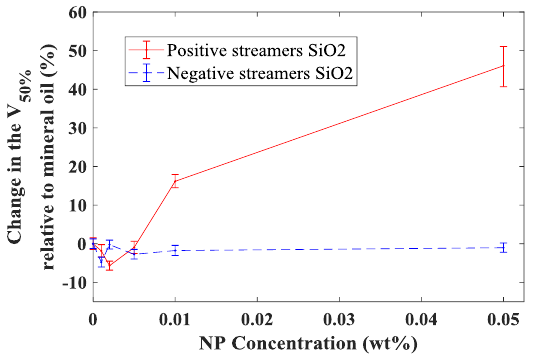
Figure 4. Change in 𝑉 50% of SiO 2 nanofluids relative to mineral oil as a function of mass fraction 𝑤 𝑖 .